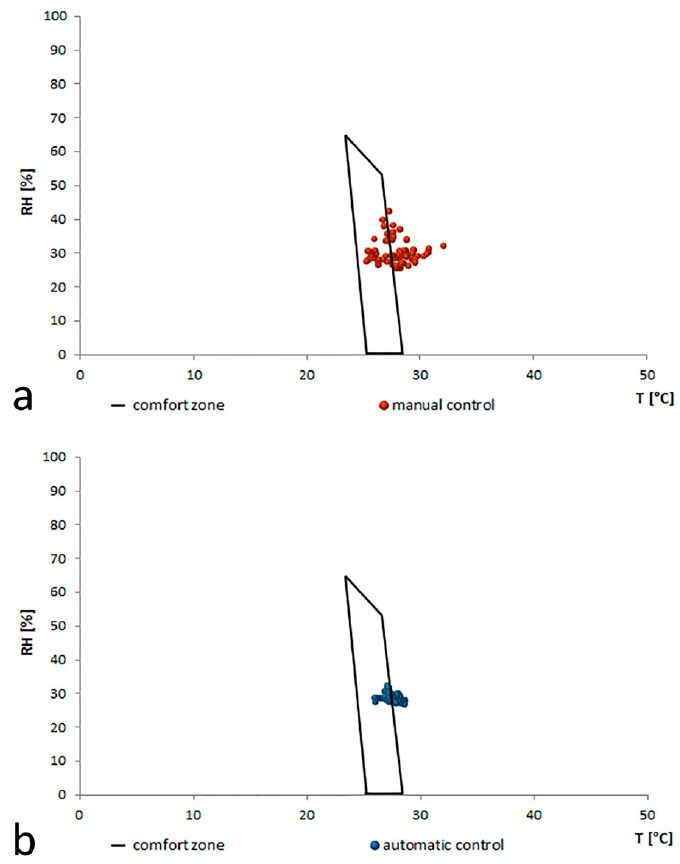
Figure 8. Graphical method of comfort zones: ( a ) manual control; ( b ) automatic control.